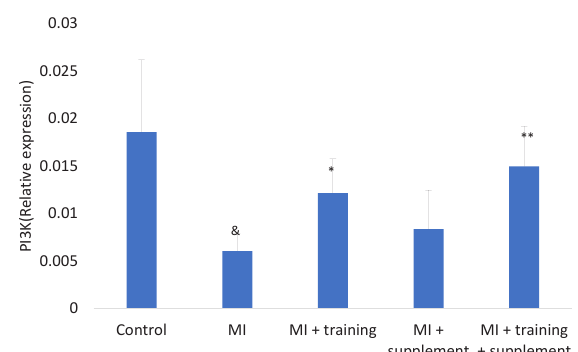
Figure 1. The mRNA expression of PI3k in the heart tissue of different study groups. The obtained values are displayed as means and standard deviation (mean ± SD). Statistically significant differences between the mean values ( P < 0.05). * P ≤0.05, ** P ≤0.01 Significant increase compared to group MI; & P ≤0.01 Significant decrease compared to control group.